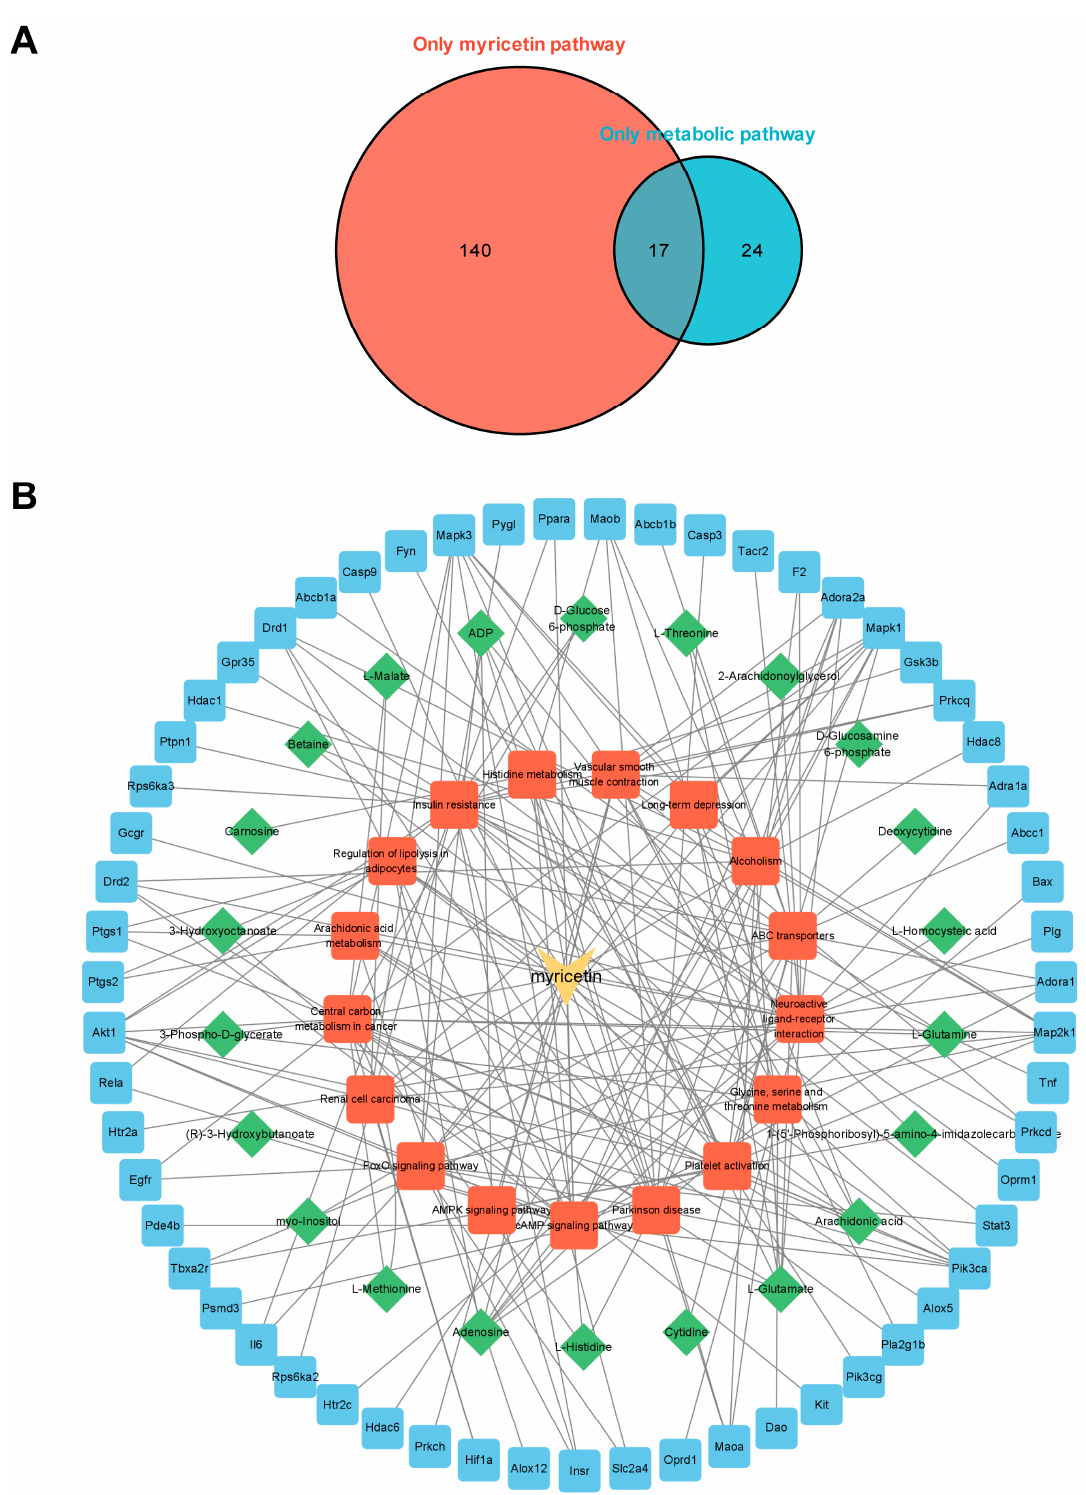
Figure 6. Network pharmacological analysis. ( A ) Venn plot of the relationship of metabolomics and network pharmacology enrichment pathways. Numbers in the red area indicate metabolic pathways enriched only in targets of myricetin, and numbers in the blue area indicate metabolic pathways enriched only in high-intensity exercise. Overlapping area indicate a common metabolic pathway. ( B ) Myricetin-pathways-metabolites-targets networks of key metabolites and targets.